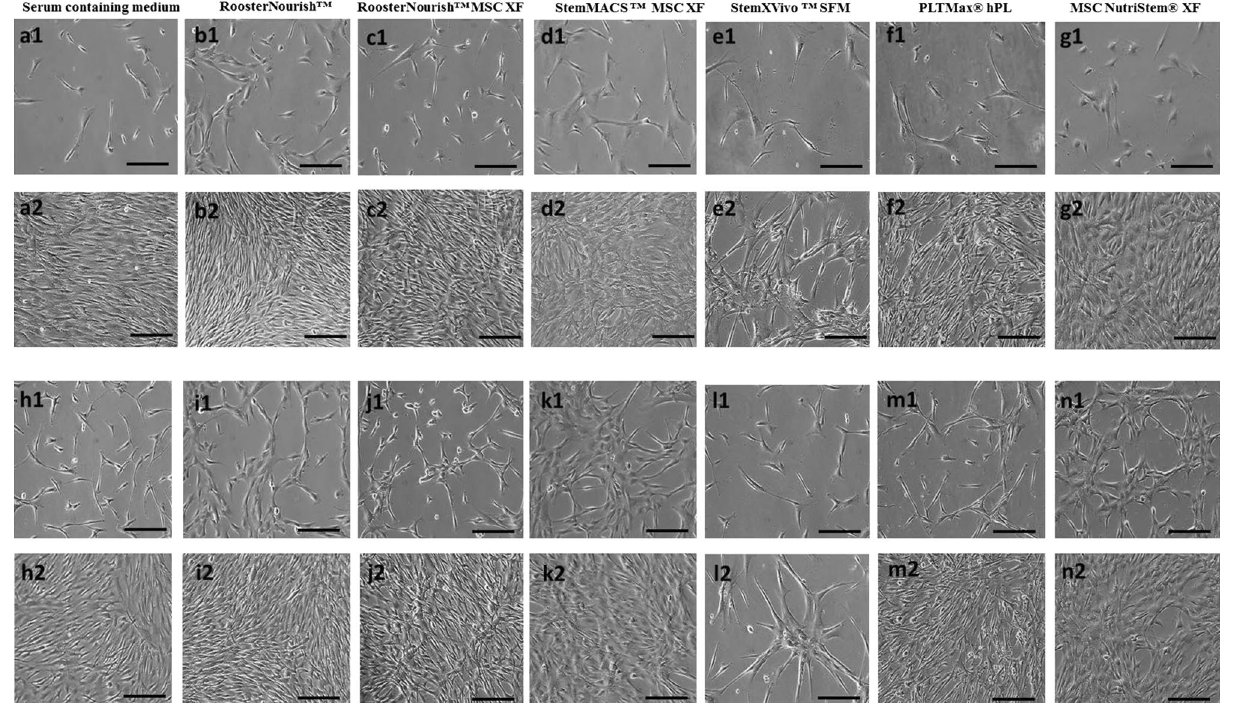
Figure 2. Morphology of BM-MSCs expanded at P5 stage. ( a1, a2, h1, h2 ) BM-MSCs cultured in DMEM-KO + 10% FBS at a seeding density of 1000 cells/cm 2 (a1, a2) and 5000 cells/cm 2 ( h1, h2 ).( a1